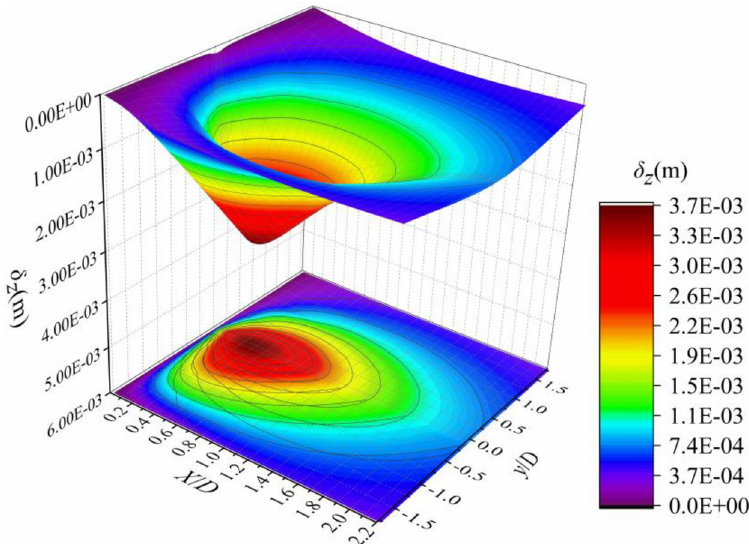
Figure 16. Three-dimensional diagram of the settlement of the surface soil.